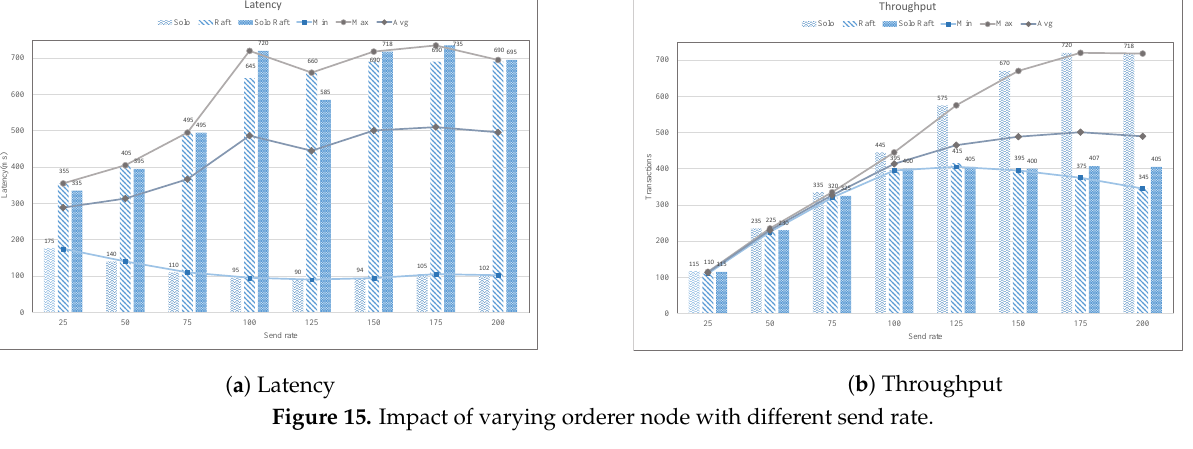
Figure 15. Impact of varying orderer node with different send